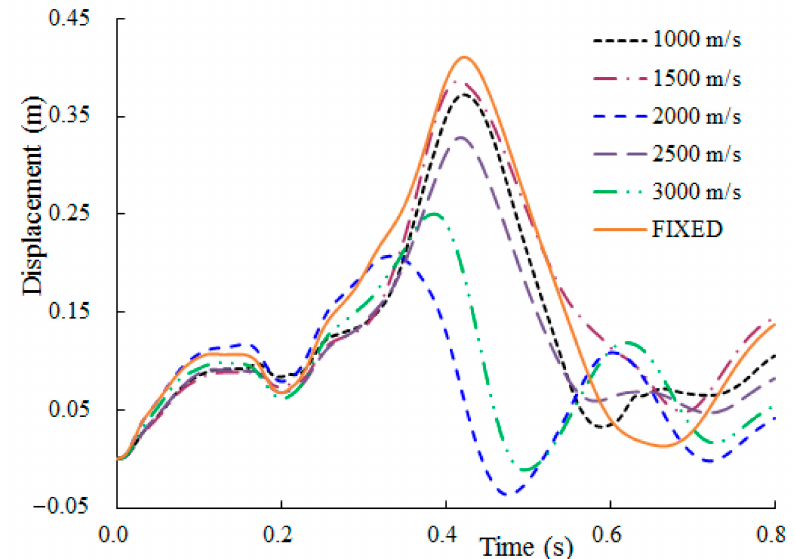
Figure 6. Max displacement time-histories of containment.